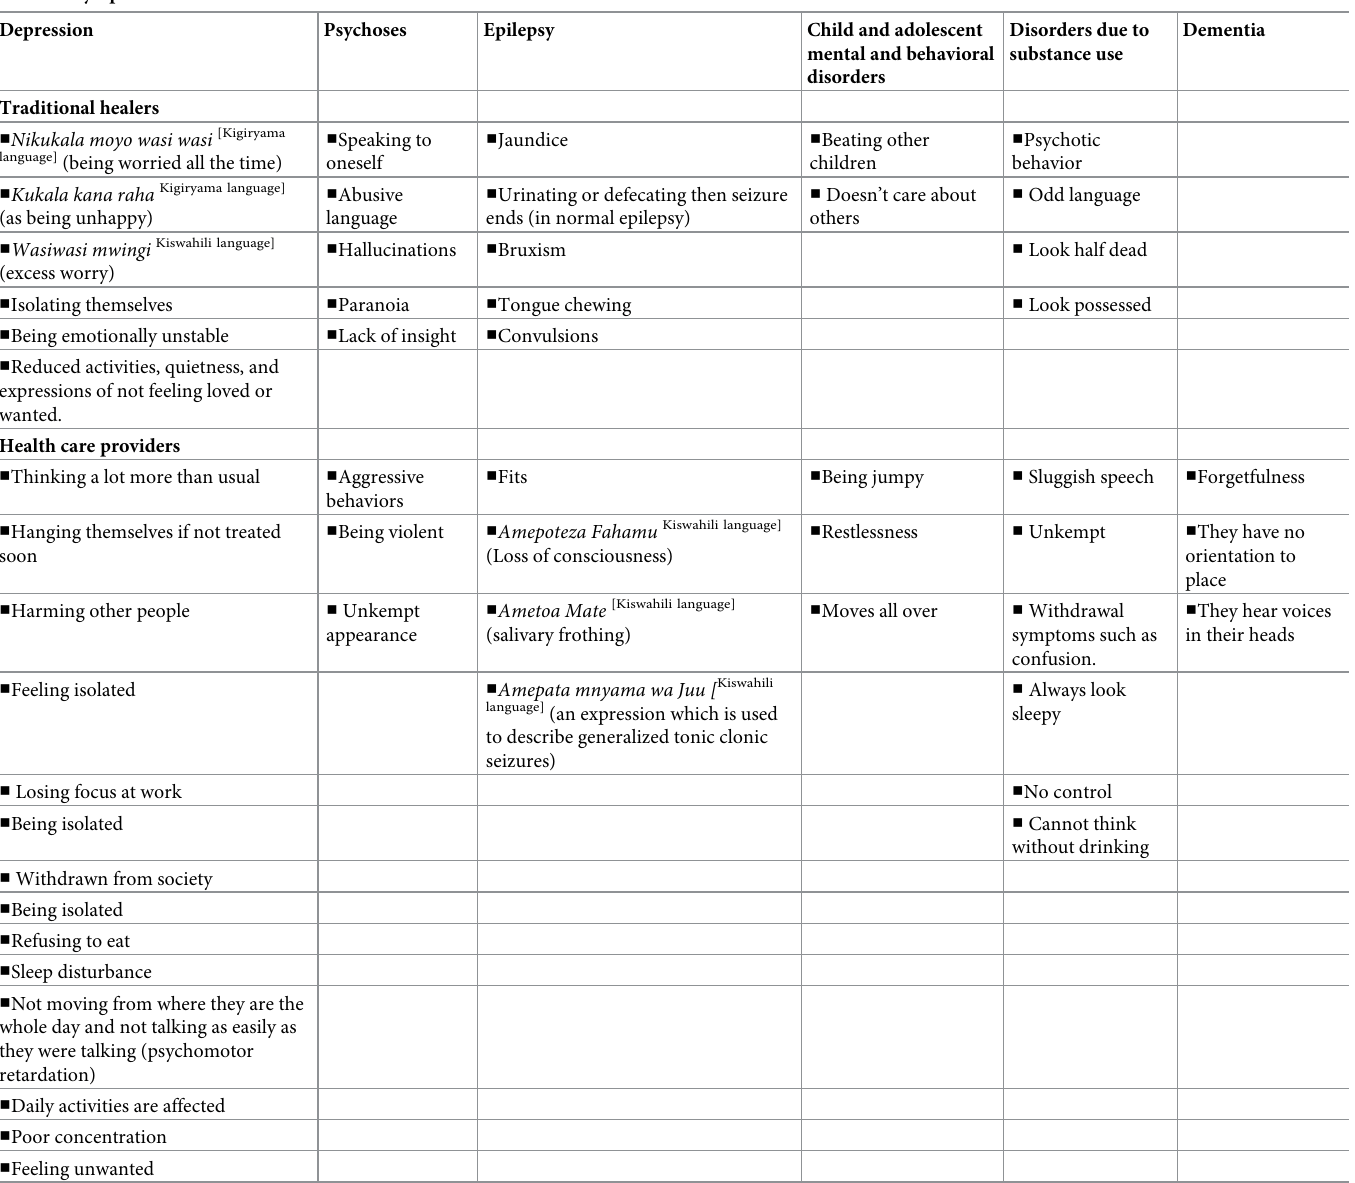
Table 3. Symptoms of common mental